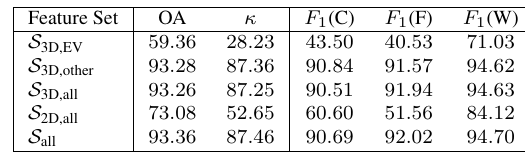
Table 1. Results (in %) achieved for the classification of the HoloLens dataset when using different feature sets as input for the classifier: Overall Accuracy (OA), κ -Index and class-wise F 1 -scores (C: Ceiling; F: Floor; W: Wall).